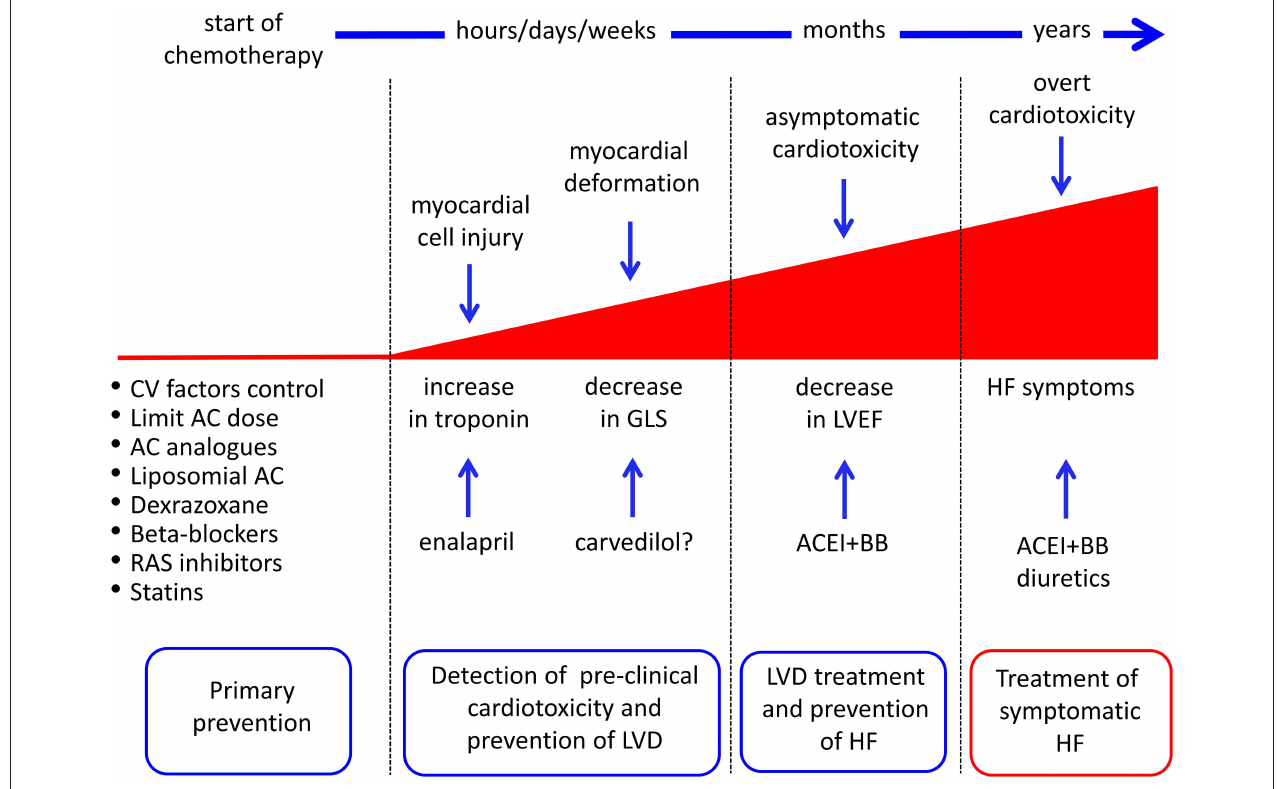
FIGURE 2 | Possible strategies for cancer drug-induced cardiotoxicity detection, prevention, and treatment. AC, anthracyclines; ACEI, angiotensin-converting enzyme inhibitors; BB, beta-blockers; CV, cardiovascular; GLS, global longitudinal strain; HF, heart failure; LVD, left ventricular dysfunction; RAS, renin-angiotensin system. From Cardinale et al. ( 8).